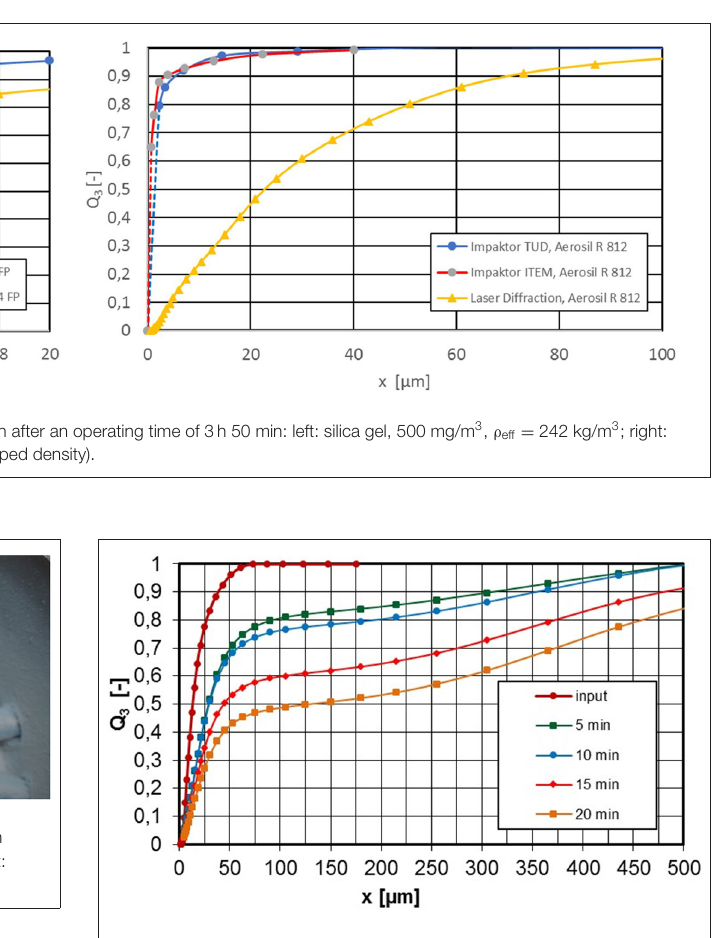
FIGURE 6 | PSD at the inlet and exhaust tube of the inhalation chamber depending on the operating time, untreated pyrogenic silica, c m = 4,700 mg/m 3 .